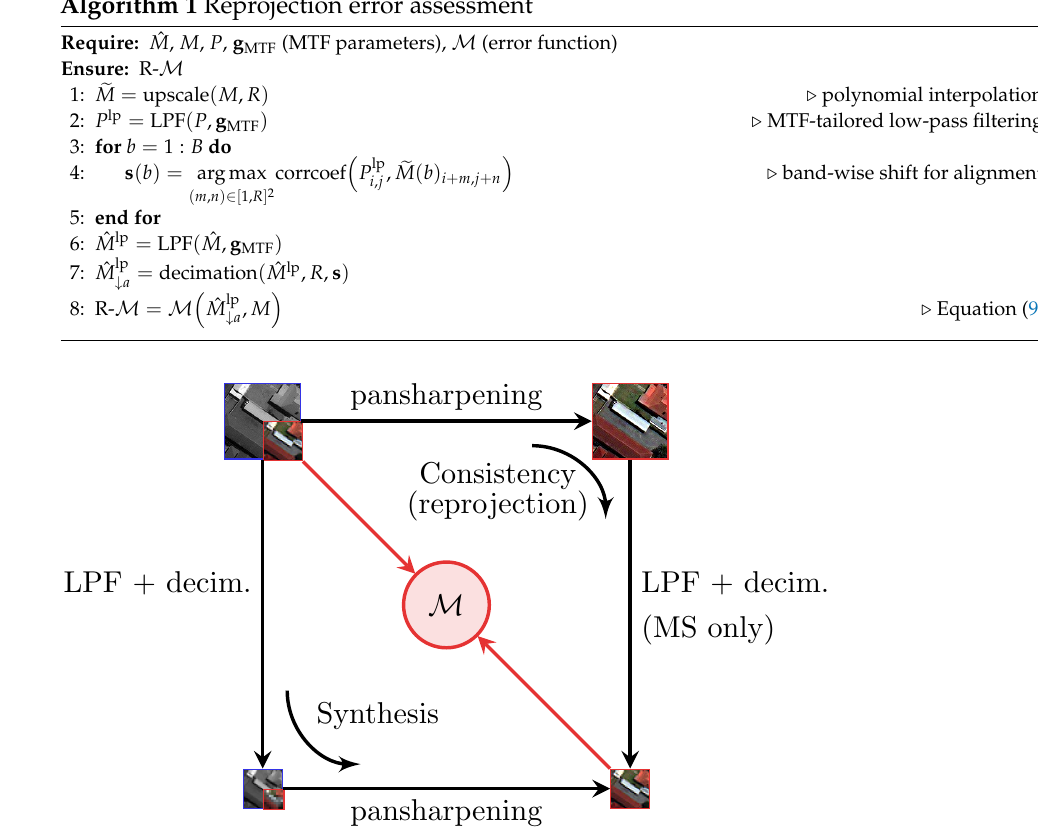
Figure 1. Spectral consistency check using reprojection (clockwise) vs. synthesis check according to Wald’s protocol (counterclockwise). is any reference-based index. In gray and red are shown the M PAN and MS channels,